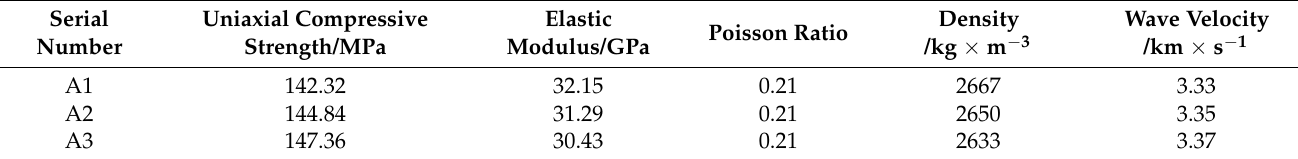
Figure 3. Stress − strain curves in the uniaxial compression test.